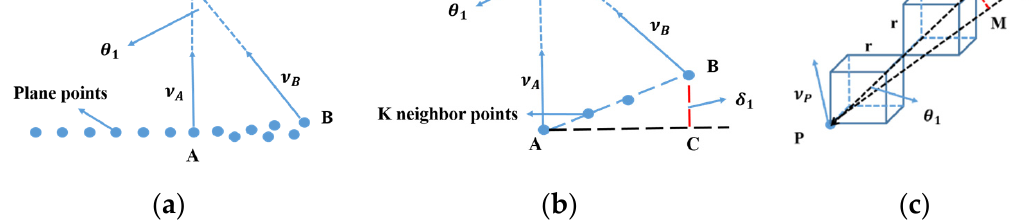
Figure 18. Parameter setting description: ( a ) region growing neighborhood, ( b ) (cid:2012) (cid:2869) , and ( c ) (cid:2012) (cid:2870) .